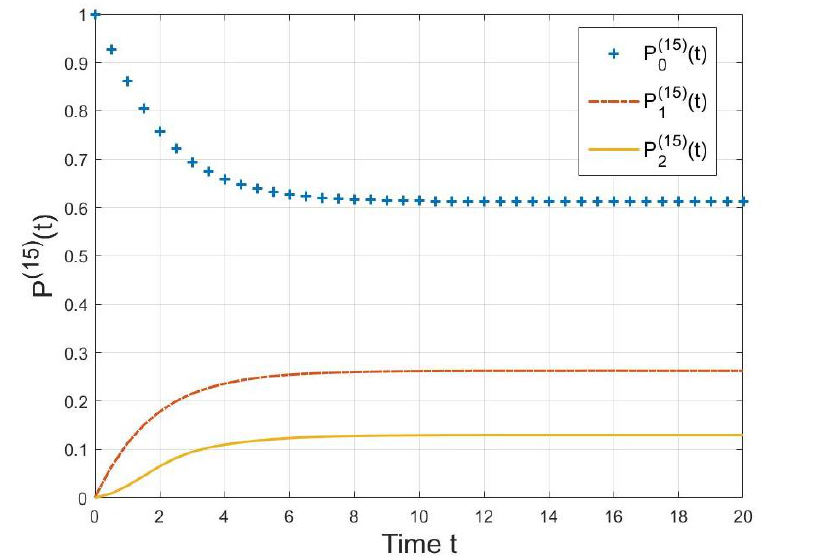
Figure 1. Probability distributions of the software